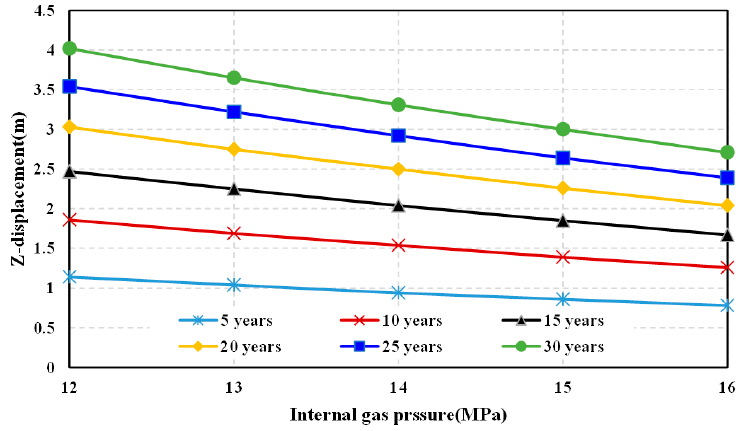
Figure 8. Z ‐ displacement versus internal gas pressure at different operating times. Figure 8. Z-displacement versus internal gas pressure at different operating